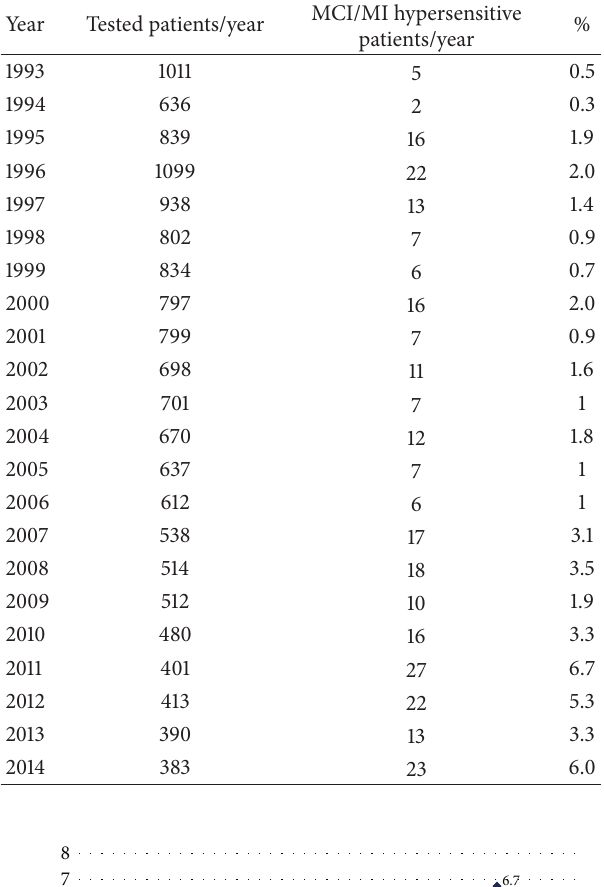
Table 1: MCI/MI hypersensitivity 1993–2014.